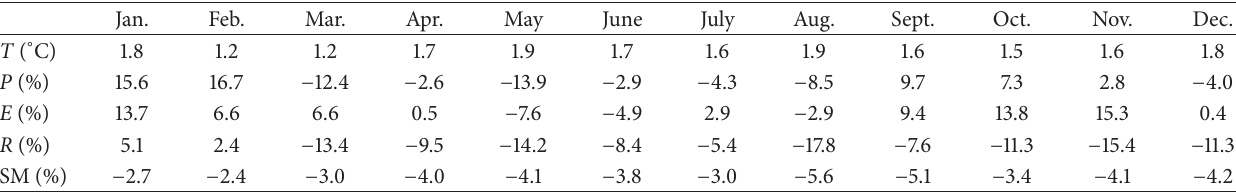
Table 5: Projected inner-annual changes in temperature ( T ), precipitation ( P ), evapotranspiration ( E ), runoff ( R ), and soil moisture (SM). Jan. Feb. Mar.